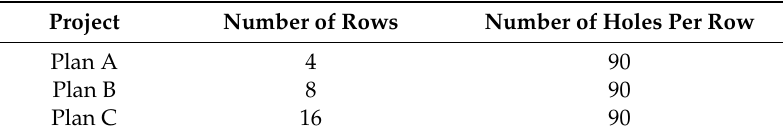
Figure 2. Simulation model of the beam expanding system. Table 1. Initial simulation schemes.